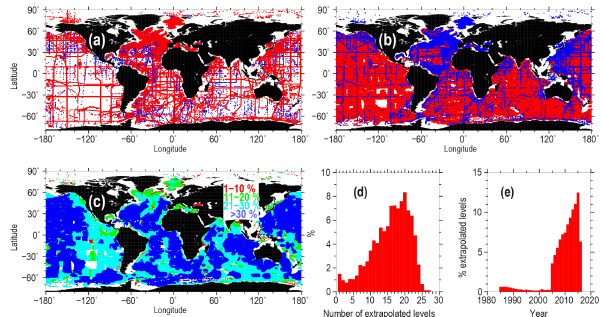
Figure 5. (a) Positions of full-depth profiles used for the extrapola- tion procedure (blue – before 1985, red – after 1984); (b) positions of extrapolated profiles (red – Argo profiles, blue – non-Argo pro- files); (c) percentage of extrapolated levels; (d) extrapolated profile frequency distribution vs. the number of extrapolated levels; and (e) extrapolated profile frequency distribution vs. the year of obser- vation.